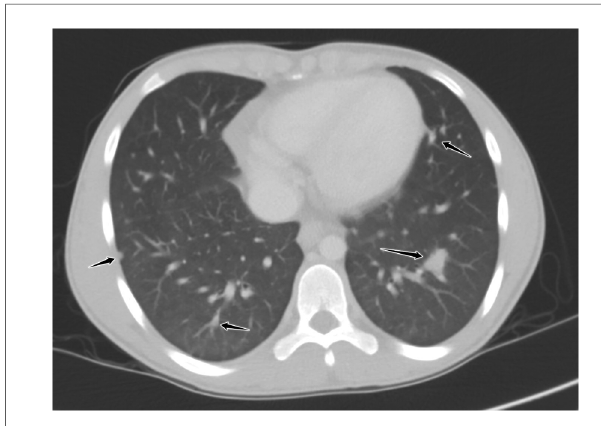
FIGURE 2 Axial reformatted, lung window CT image through the lower chest demonstrating multiple noncalci fi ed, well-demarcated pulmonary nodules throughout all lobes (black arrows).